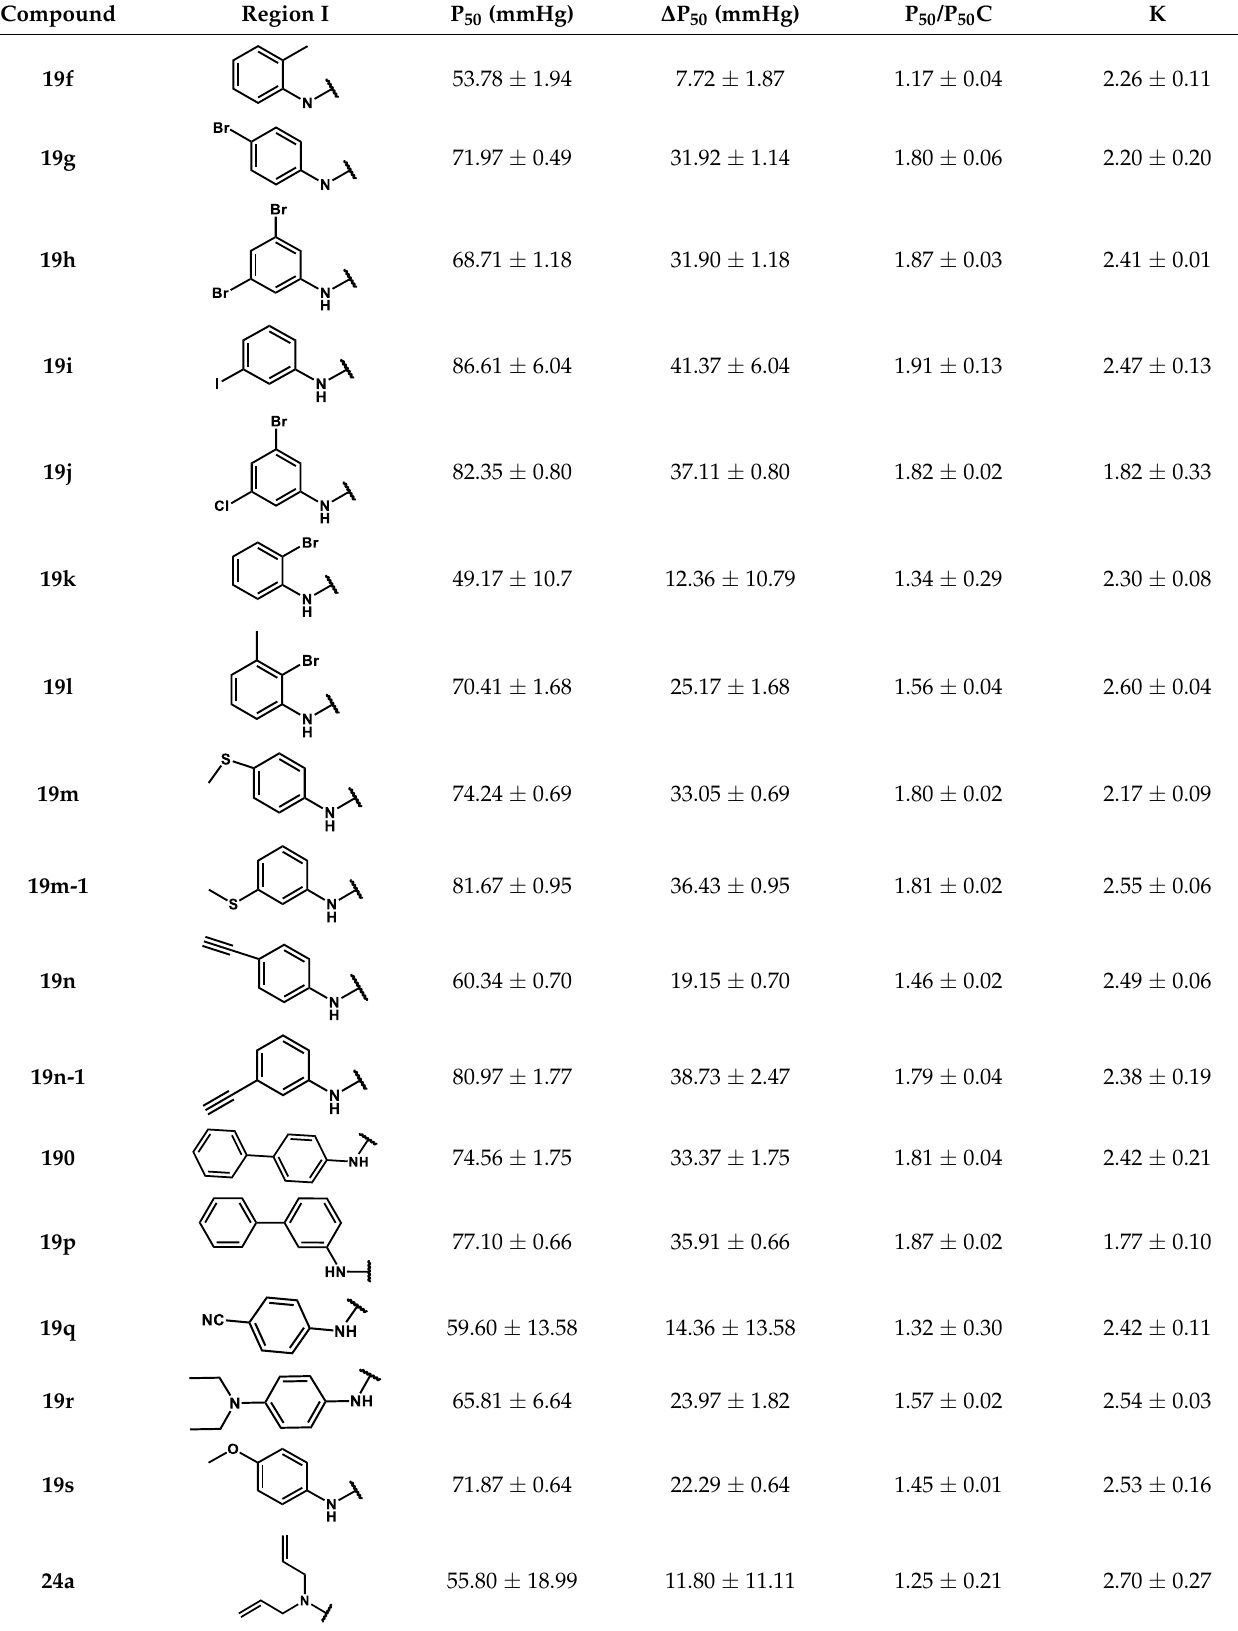
Table 1. Results of in vitro red blood cell studies.